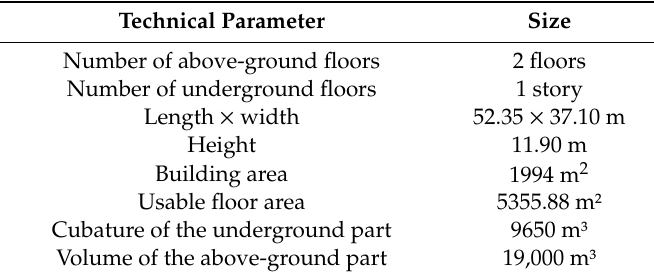
Table 1. Technical parameters of the sports facility